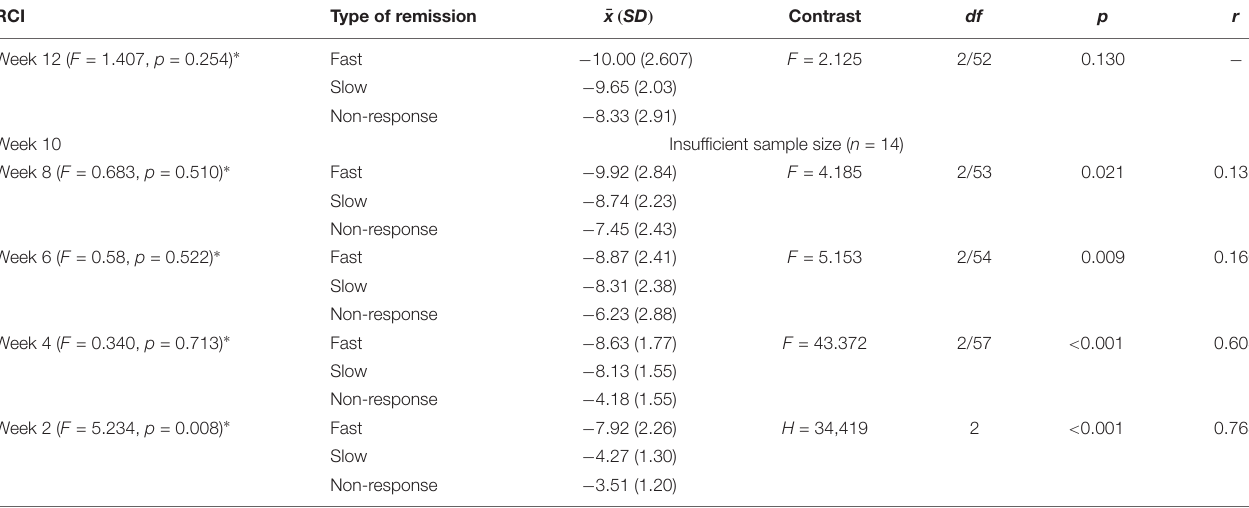
TABLE 10 | Mean, bivariate analysis (ANOVA), and homogeneity test of the variables RCI in the different weeks and the type of remission. RCI Type of remission ¯ x ( SD ) Contrast df p r Week 12 ( F = 1.407, p = 0.254) ∗